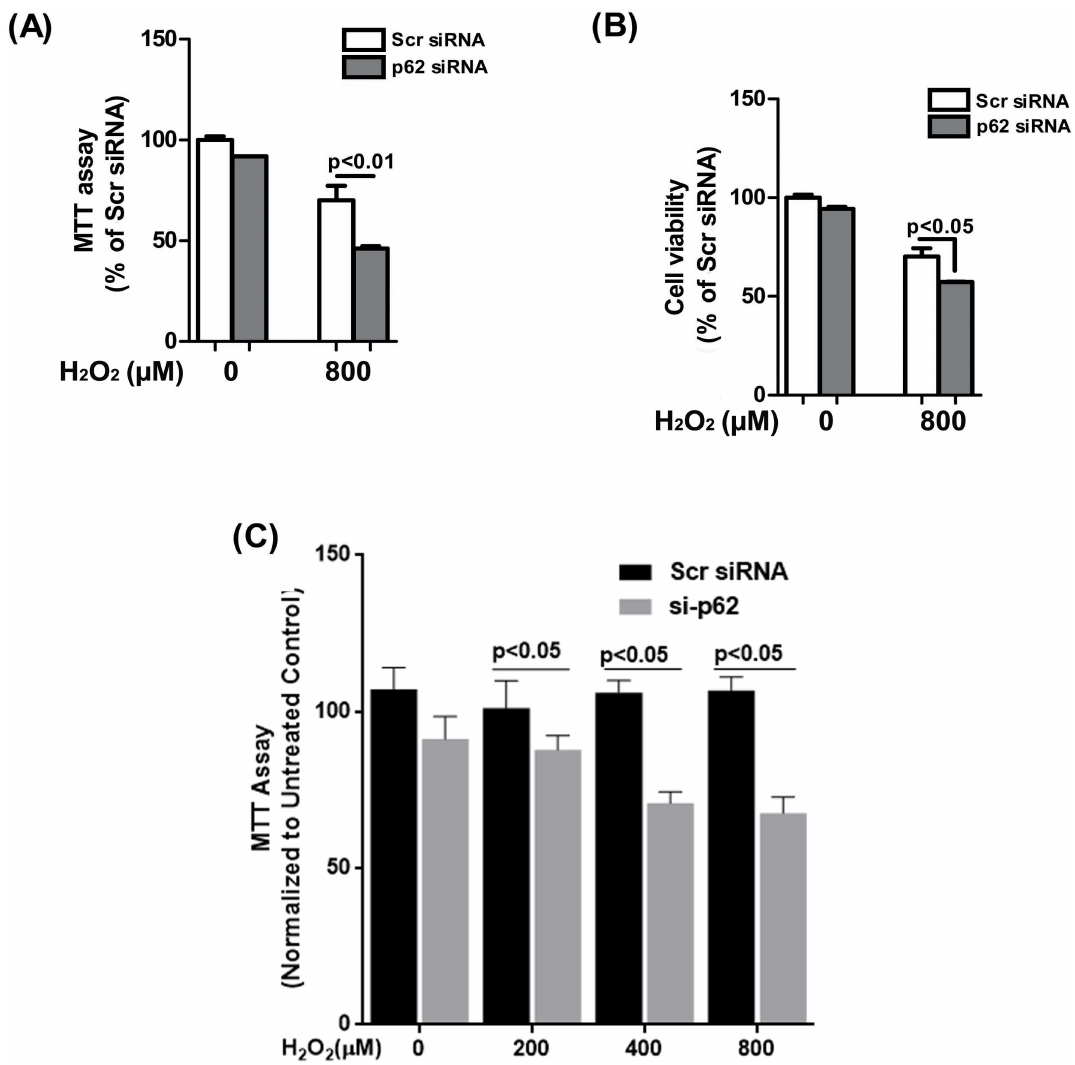
Fig 6. Knockdown of p62 renders RPE cells more susceptible to oxidative stress. ARPE-19 cells were transfectedwith p62 or scrambledsiRNA for 24h and then treated with 800 μ MH 2 O 2 for 6h. (A) Mitochondrial activity in p62 or scrambled siRNA-transfected cells was assessedusing MTT assay. (B) Cell viabilitywas assayed using crystal violet assay. Statistical significance was calculatedby ANOVA and differences were considered statistically significantwhen p < 0.05. (C) Primary fetal RPE cells were transfected with p62 or scrambledsiRNA for 48h and then treated with varying concentrations of H 2 O 2 for 24h followedby MTT assay. Statistical significancewas calculatedby ANOVA and differences were considered statistically significantwhen p <